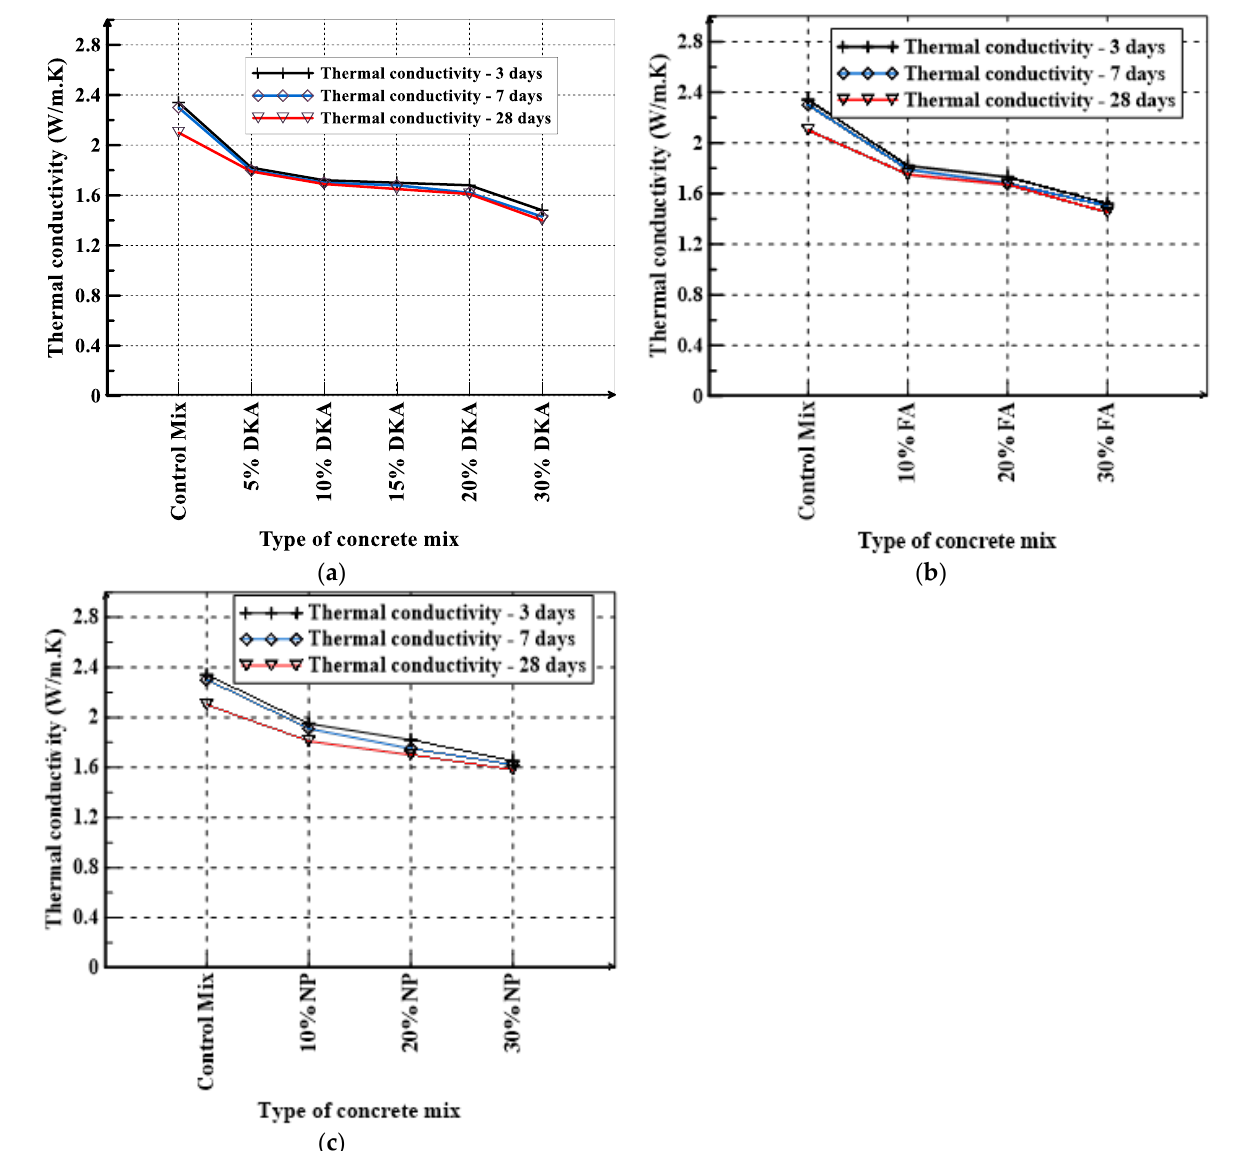
Figure 19. Thermal conductivity of ( a ) DKA, ( b ) FA, and ( c ) NP concrete mixes. The maximum thermal resistance was measured for the concrete mix with 30% DKA at the age of 28 days with a value of 85.6 ◦ C.cm/W. Compared to the FA and NP mixes, the thermal resistance of the DKA mixes is higher, as can be seen in Figure 20a–c.